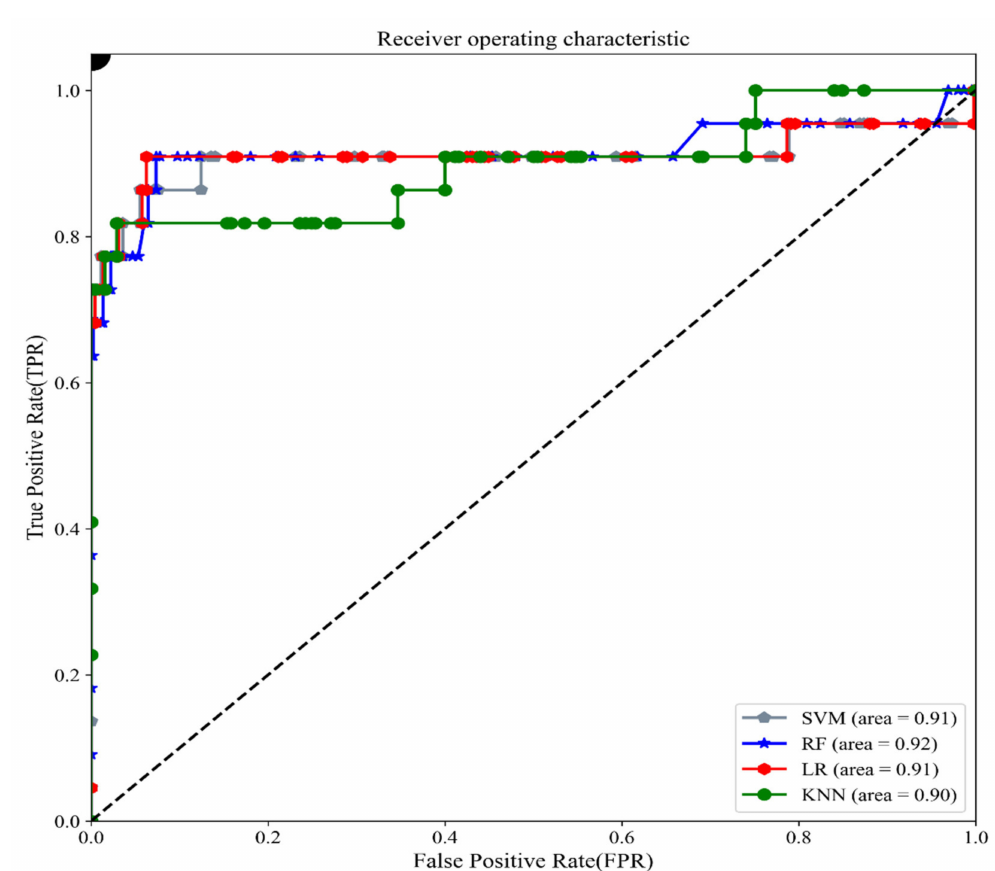
Figure 8. ROC curves of KNN, LR, RF, and SVM on robust data after being filtered by multi-source semantic